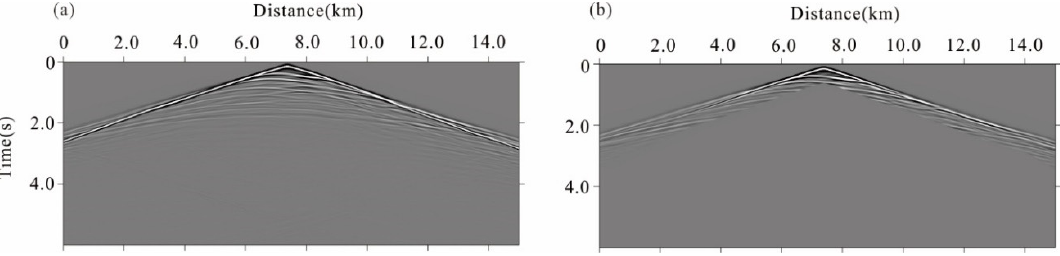
Figure 4. Schematic showing the ( a ) Simulated seismogram obtained from the overthrust model in Figure 4a; ( b ) Early arrival wavefields extracted from the seismogram in ( a ).